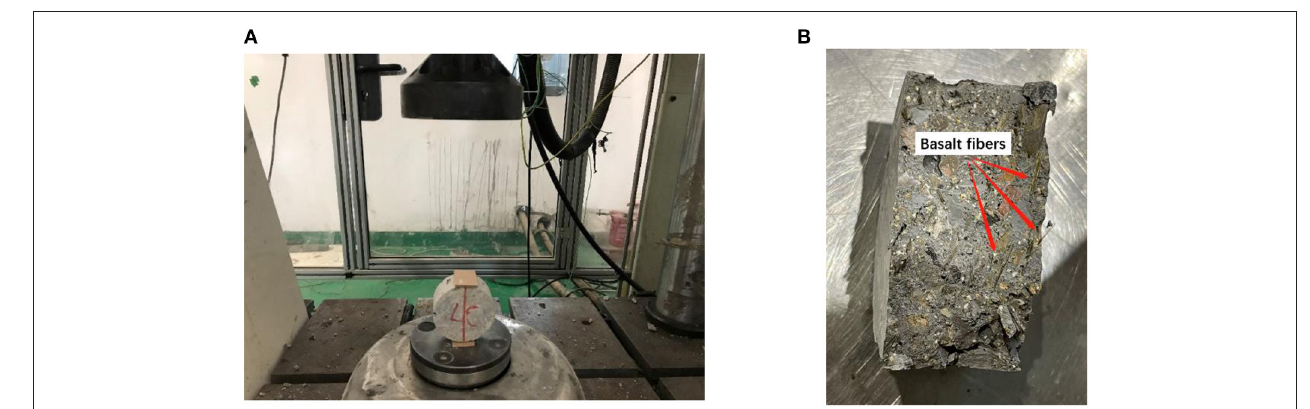
FIGURE 7 | Illustration of dynamic splitting tensile test setup and failure mode of BFRAAC. (A) Test setup. (B) Failure mode.